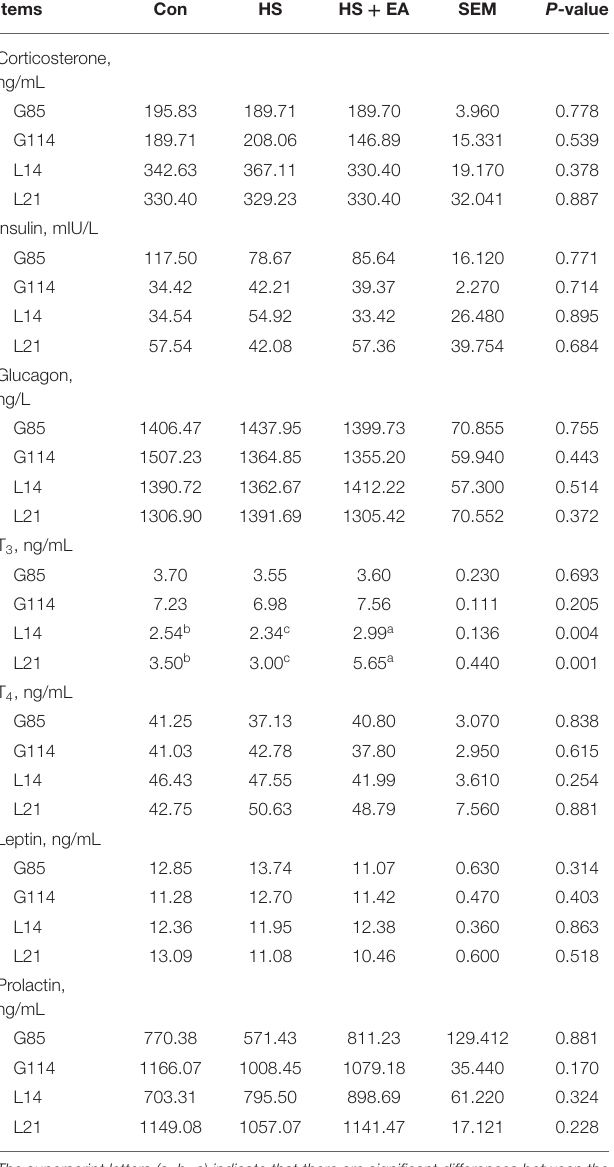
TABLE 4 | Effects of dietary supplementation with EA on endotoxin and HSP-70 levels in the serum of sows.